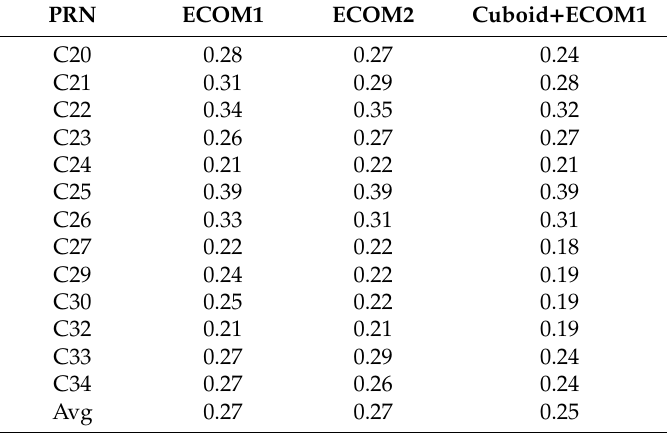
Table 9. RMS of the clock o ff set residuals, fitted by a quadratic polynomial for a 3-day arc. The unit is